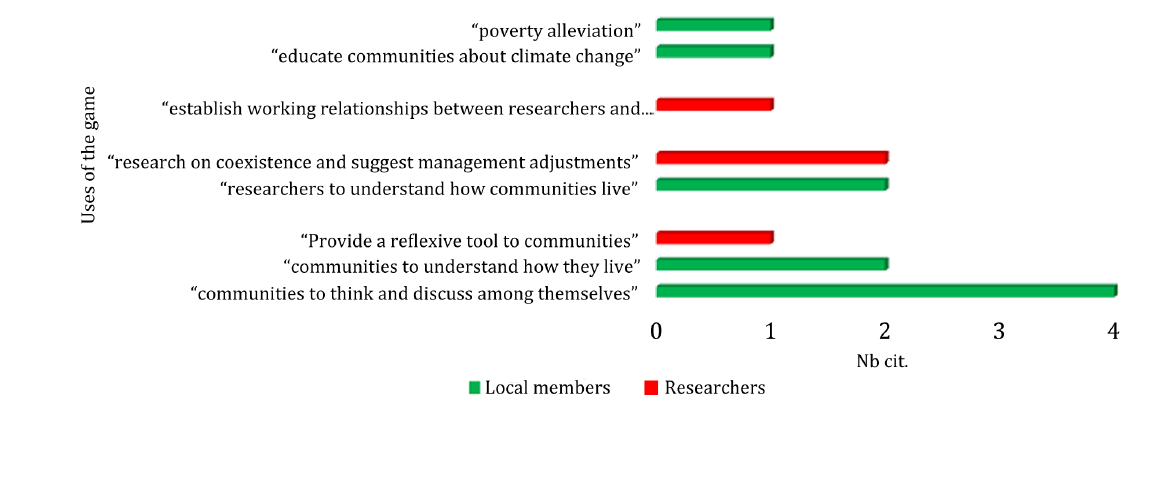
Fig. 5. Potential future uses of the game as perceived by the team members. The different potential uses of the game were given by local members (green, n = 10) and researchers (red, n = 3) in the questionnaire survey administered before the playing sessions (May